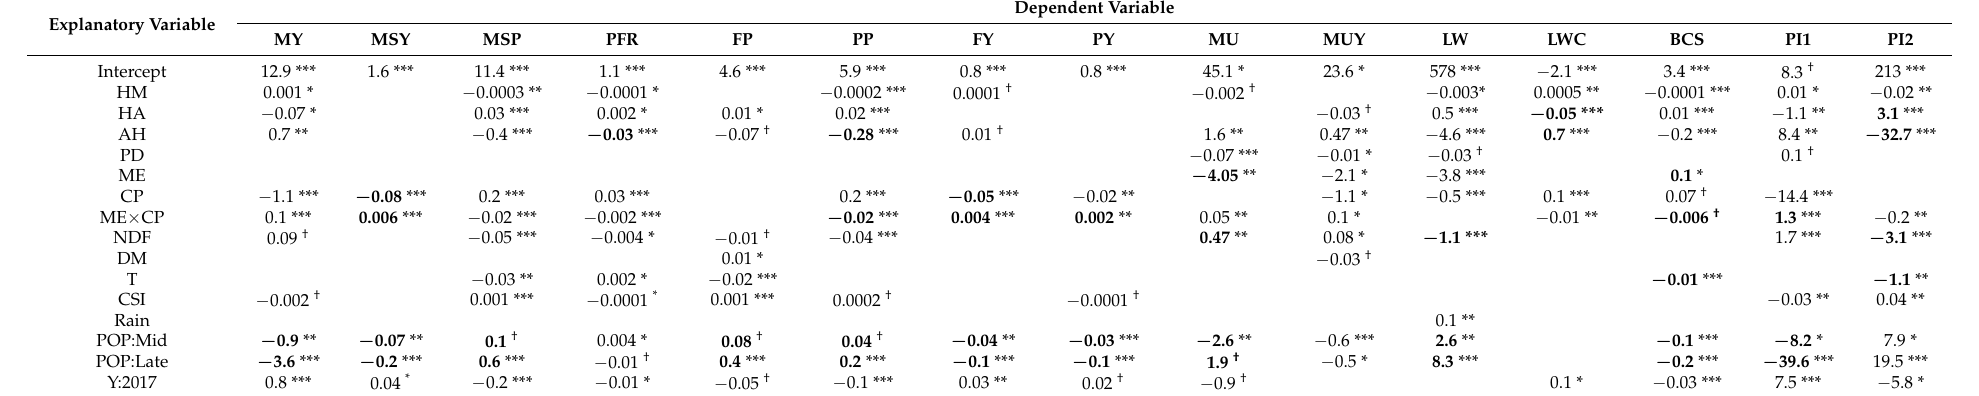
Table 5. Regression coefficients of herbage nutritive value, herbage quantity and climate variables explaining responses in performance per cow. Explanatory